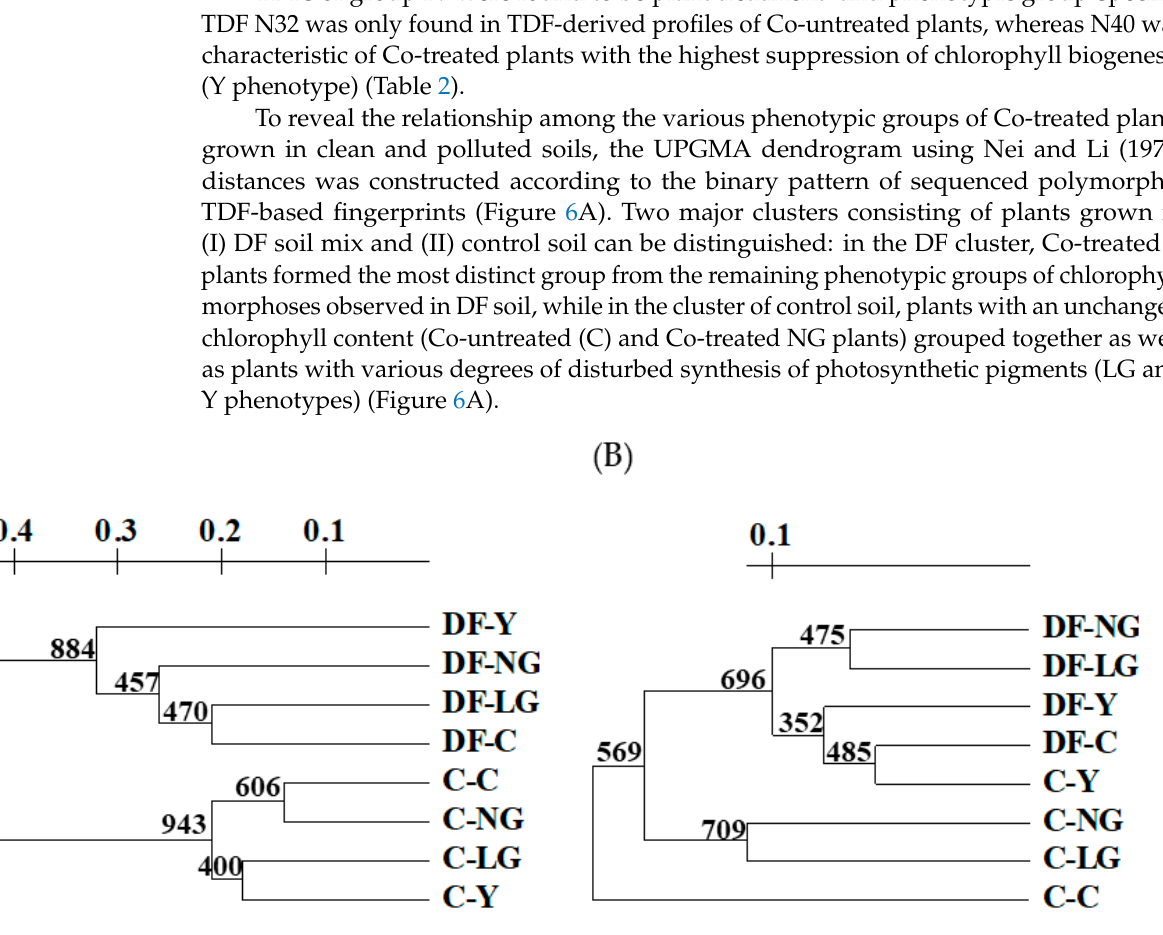
Figure 6. UPGMA dendrograms were generated using the conserved DNA-derived polymorphism (CDDP) ( A ) and variation in the profiles of transcript-derived fragments (TDFs) ( B ). The Nei and Li genetic distances are presented on the axis, and bootstrap values from 1000 iterations are shown at the branch